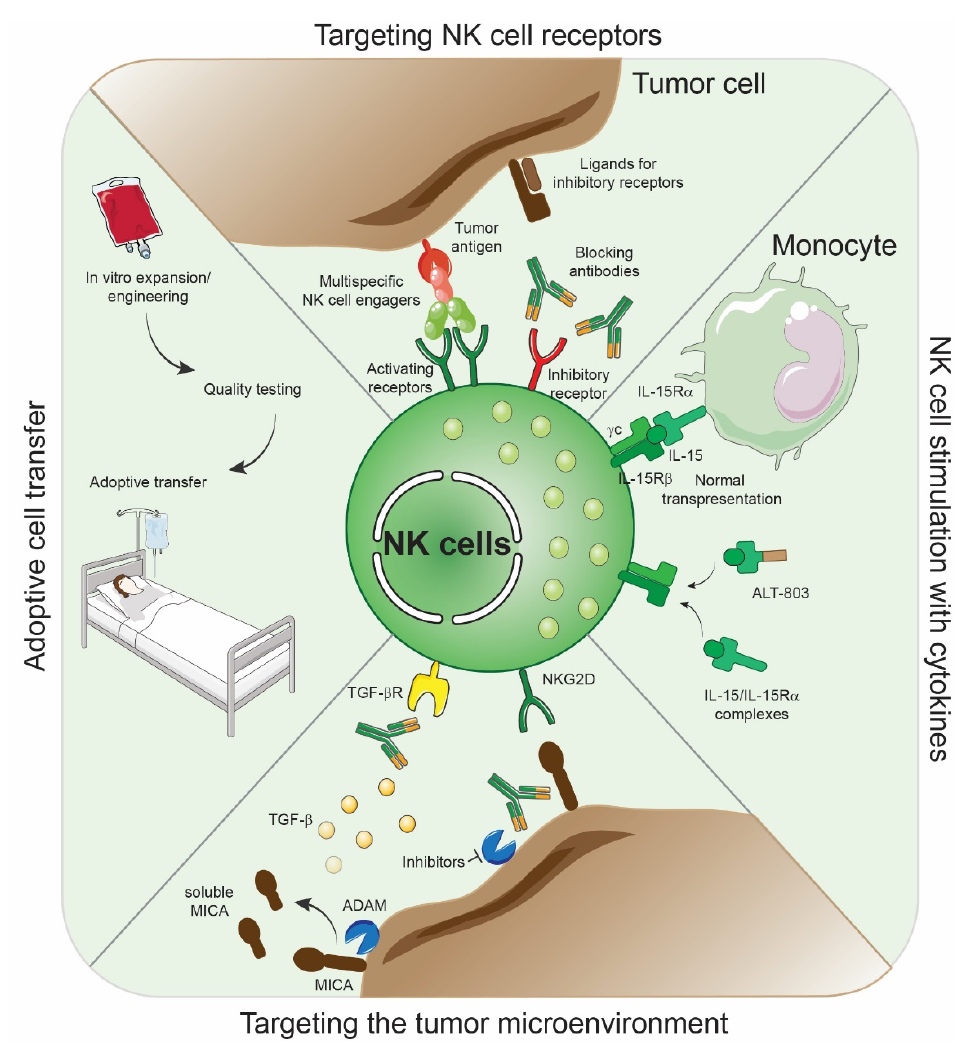
Figure 3. NK cell-directed therapeutic strategies in HCC. Current therapeutic approaches based on NK cell manipulation. Four different strategies are currently being explored. This includes (i) the interference of NK cell receptors to either block the inhibitory receptors or stimulate activating receptors; (ii) the adoptive transfer of autologous/allogeneic NK cells; (iii) the stimulation of NK cells by activating cytokines or (iv) the manipulation of the microenvironment by inhibiting the immunosuppressive pathways found in HCC patients.